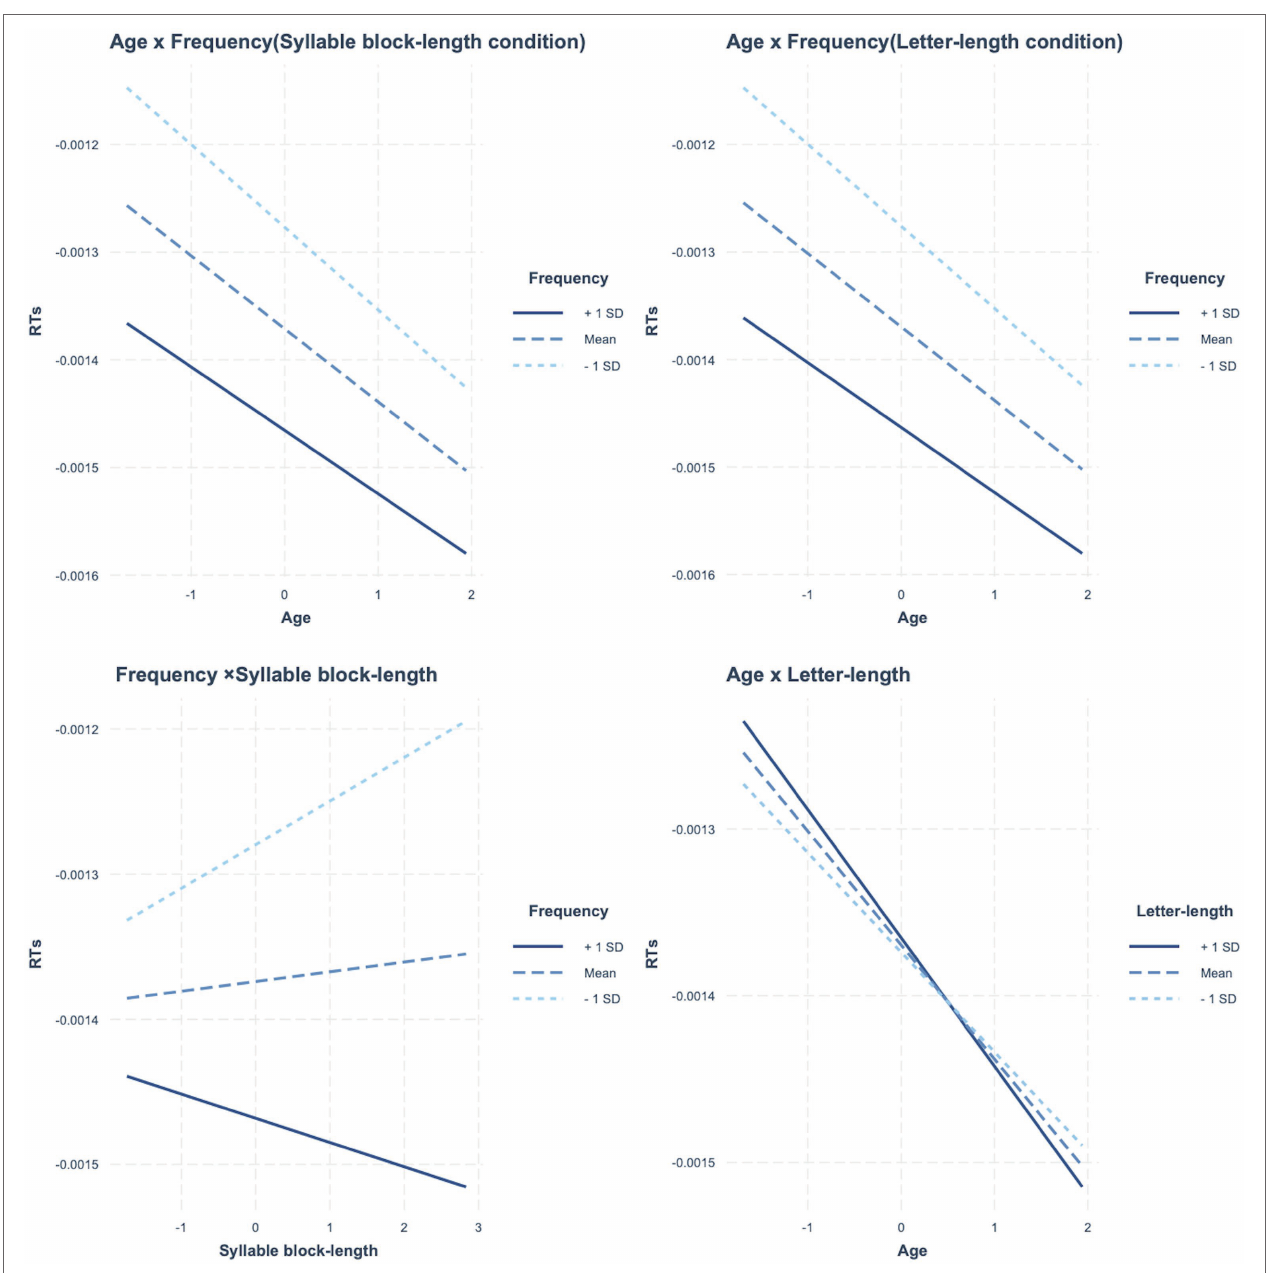
FIGURE 4 | In reading latencies for words, significant interactions. Top panels : interaction between age and frequency in two type of length conditions. Bottom panels : interaction between frequency and syllable block length (left), age and letter length